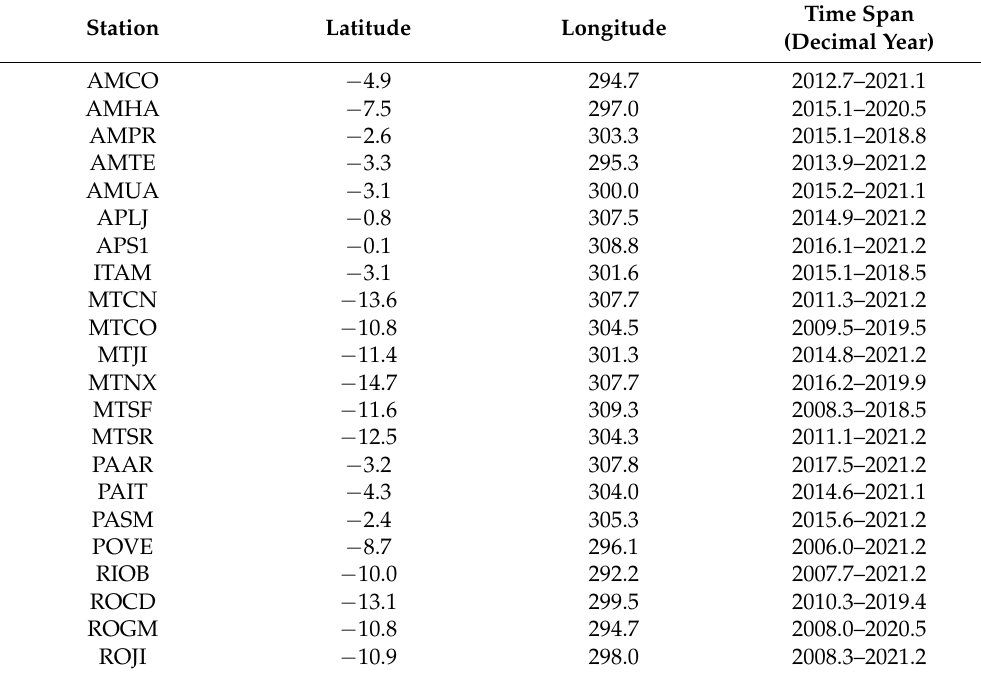
Table 1. Geographic coordinates and time spans at the 22 Global Navigation Satellite System (GNSS)